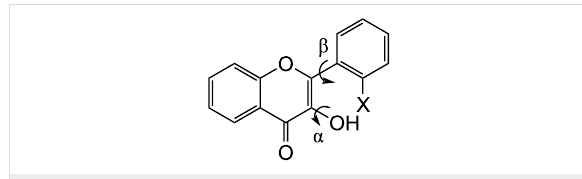
Figure 1: 2'-Haloflavonols and the α and β torsional